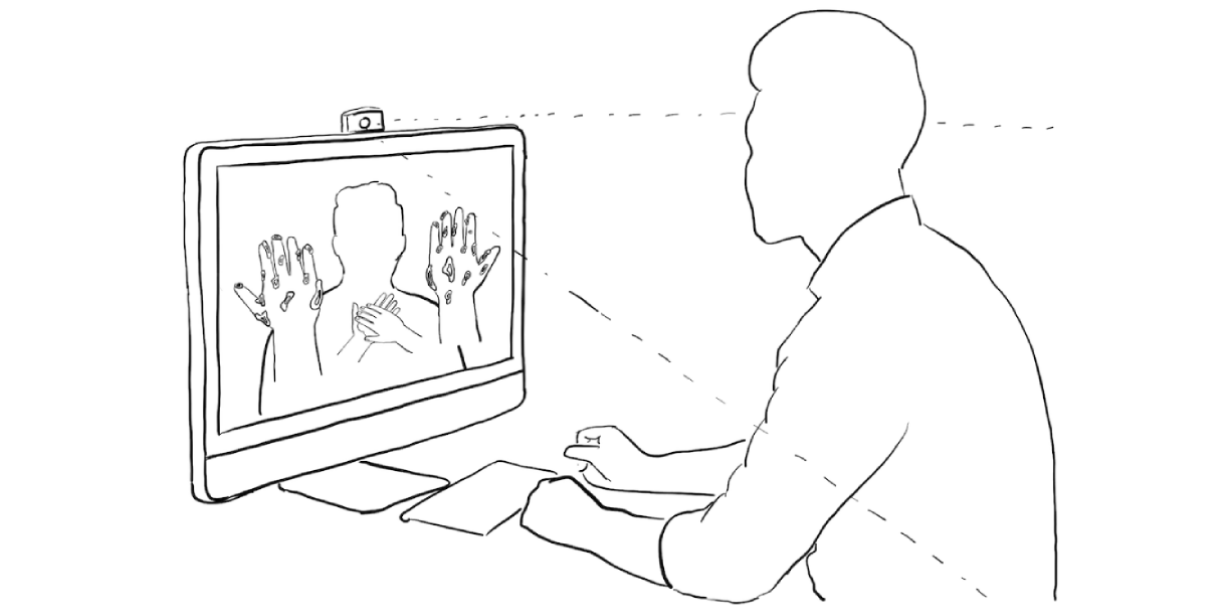
Figure 1. A participant in one of the self-focused augmented reality design groups viewing a reflection of themselves using a video feed from their